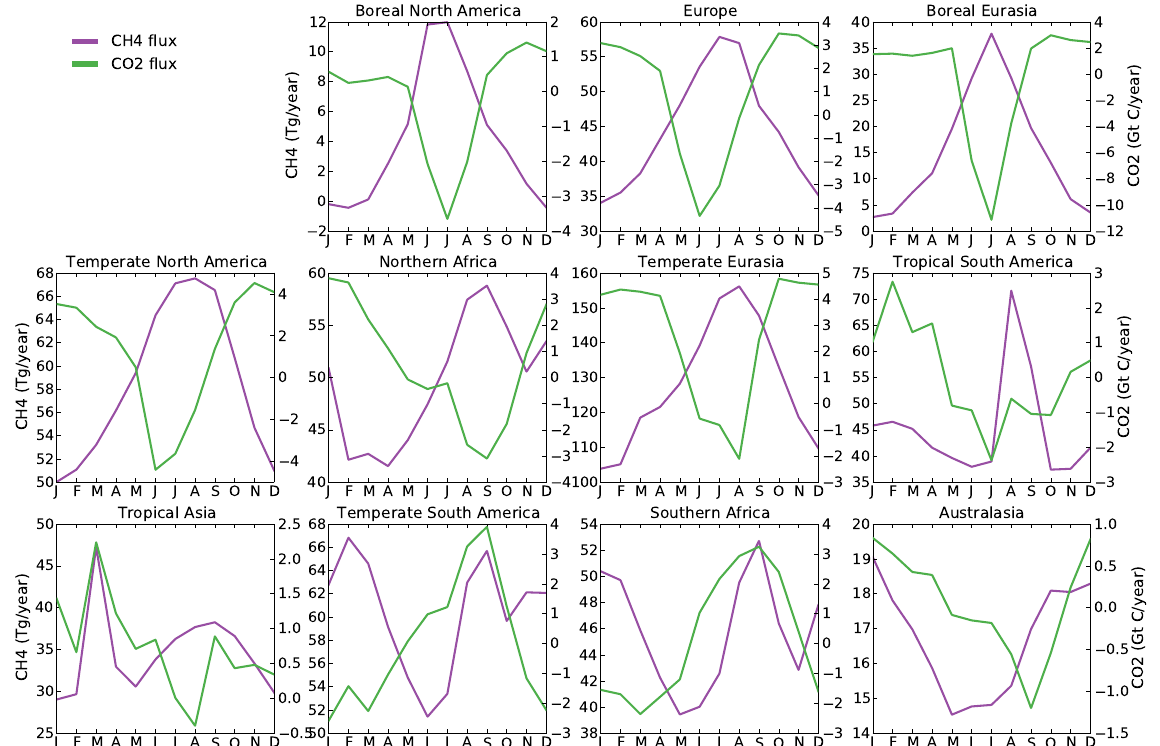
Figure 3. Monthly a priori emissions for CH 4 (TgCH 4 year − 1 ) and CO 2 (GtCyear − 1 ) for the land regions shown in Fig. 1. Note the different y